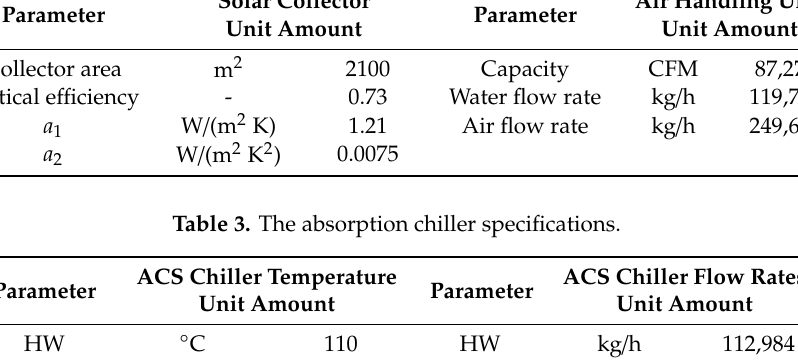
Table 2. Evacuated tube collector and air handling unit specifications.